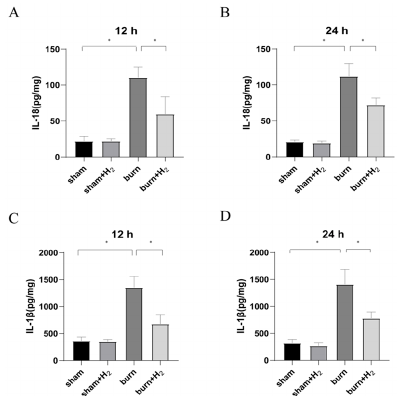
Figure 4. Effects of hydrogen treatment after burn injury on the inflammatory response in rat lung tissues. The levels of IL-18 ( A , B ) and IL-1 β ( C , D ) in lung tissue in each group were measured with ELISA kits ( n = 6 rats per group). * p < 0.05.